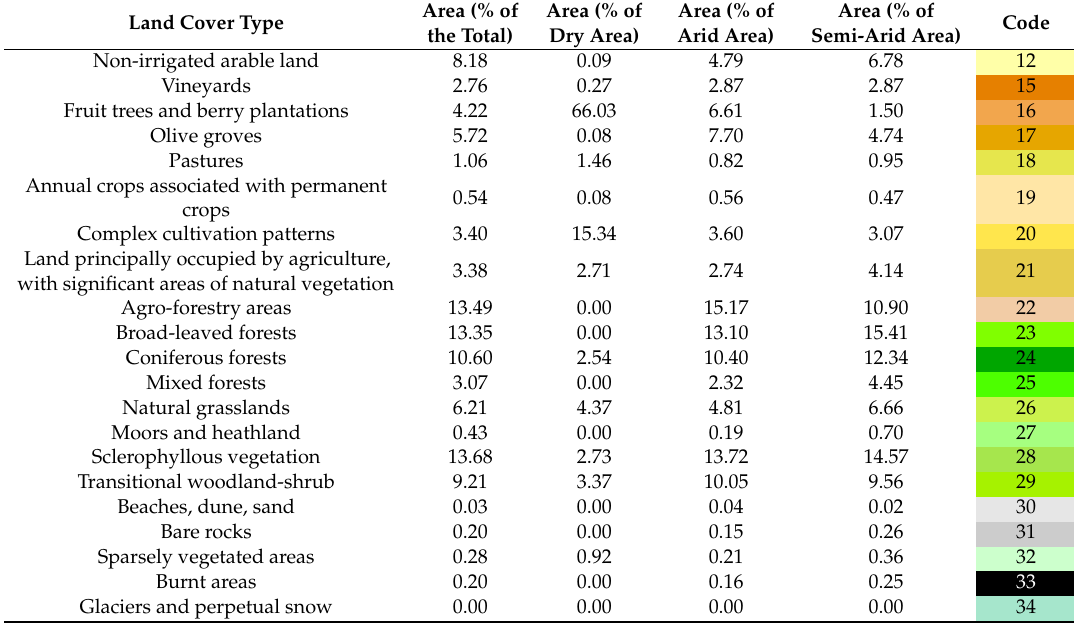
Figure 1. ( a ) Aridity classification of the Iberian Peninsula (IP) and ( b ) selected CLC 2006 land cover types occurring in the study area. Land cover labels are shown in Table 1. Table 1. Land cover types and corresponding area occurring in the study area, in dry, semi-arid, and arid areas, and code (numeric and color) used in Figures 1b and 7.